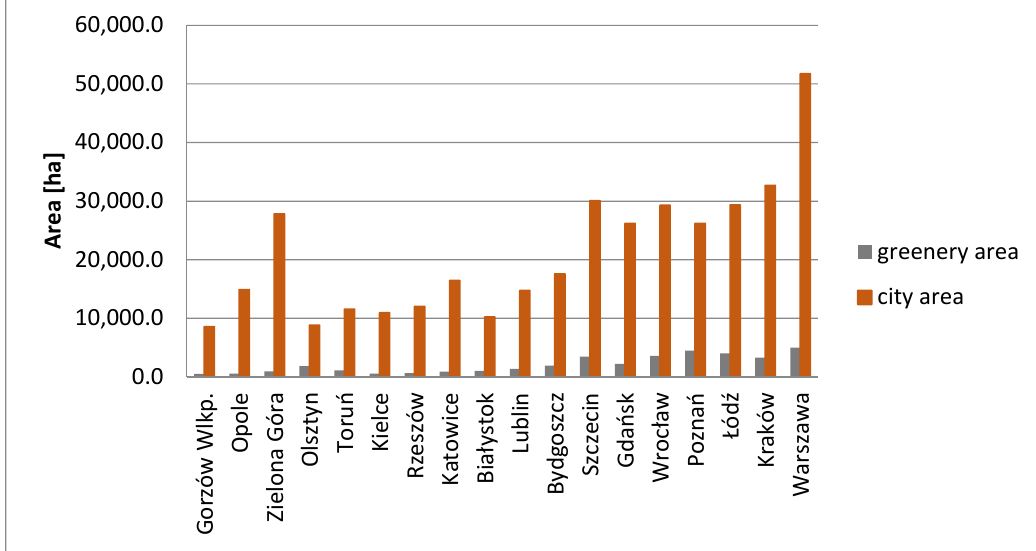
Figure 2. The area of cities and green spaces by the increasing number of residents.